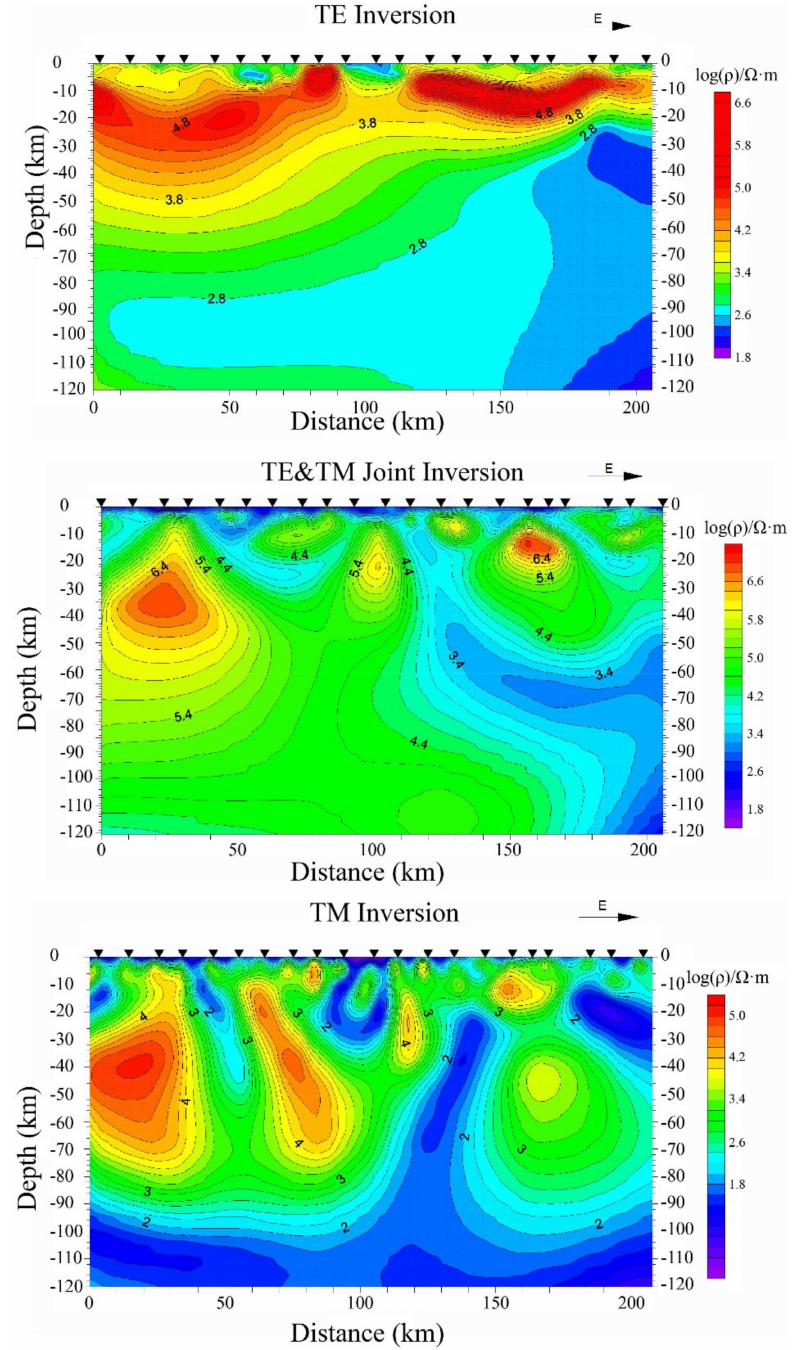
Figure 5. Compares of NLCG 2D inversion result of three inversion models (TE, TE and TM, and TM) of MT profile